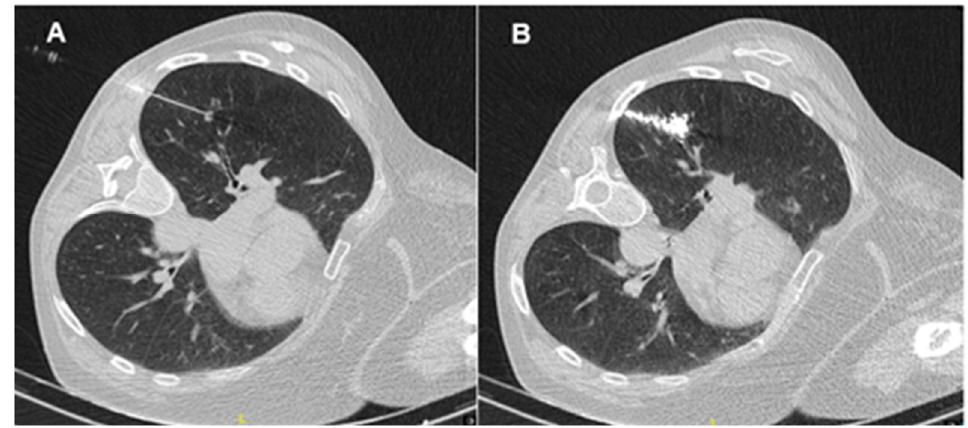
Figure 1. ( A ): CT-guided preoperative localization technique with needle; ( B ): CT-guided preopera- tive localization technique with microcoil marking in the nodule.